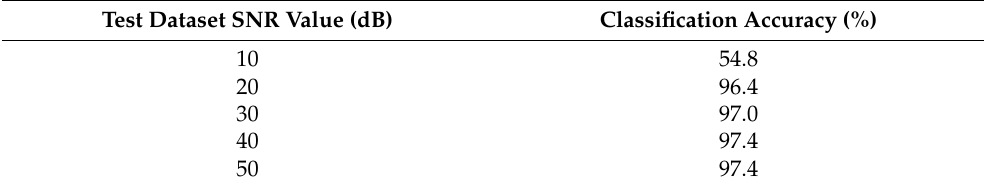
Table 4. The classification accuracy of the proposed model under different SNR values of the test dataset for the training dataset with SNR values of 10 dB, 20 dB, 30 dB, 40 dB, and 50 dB.